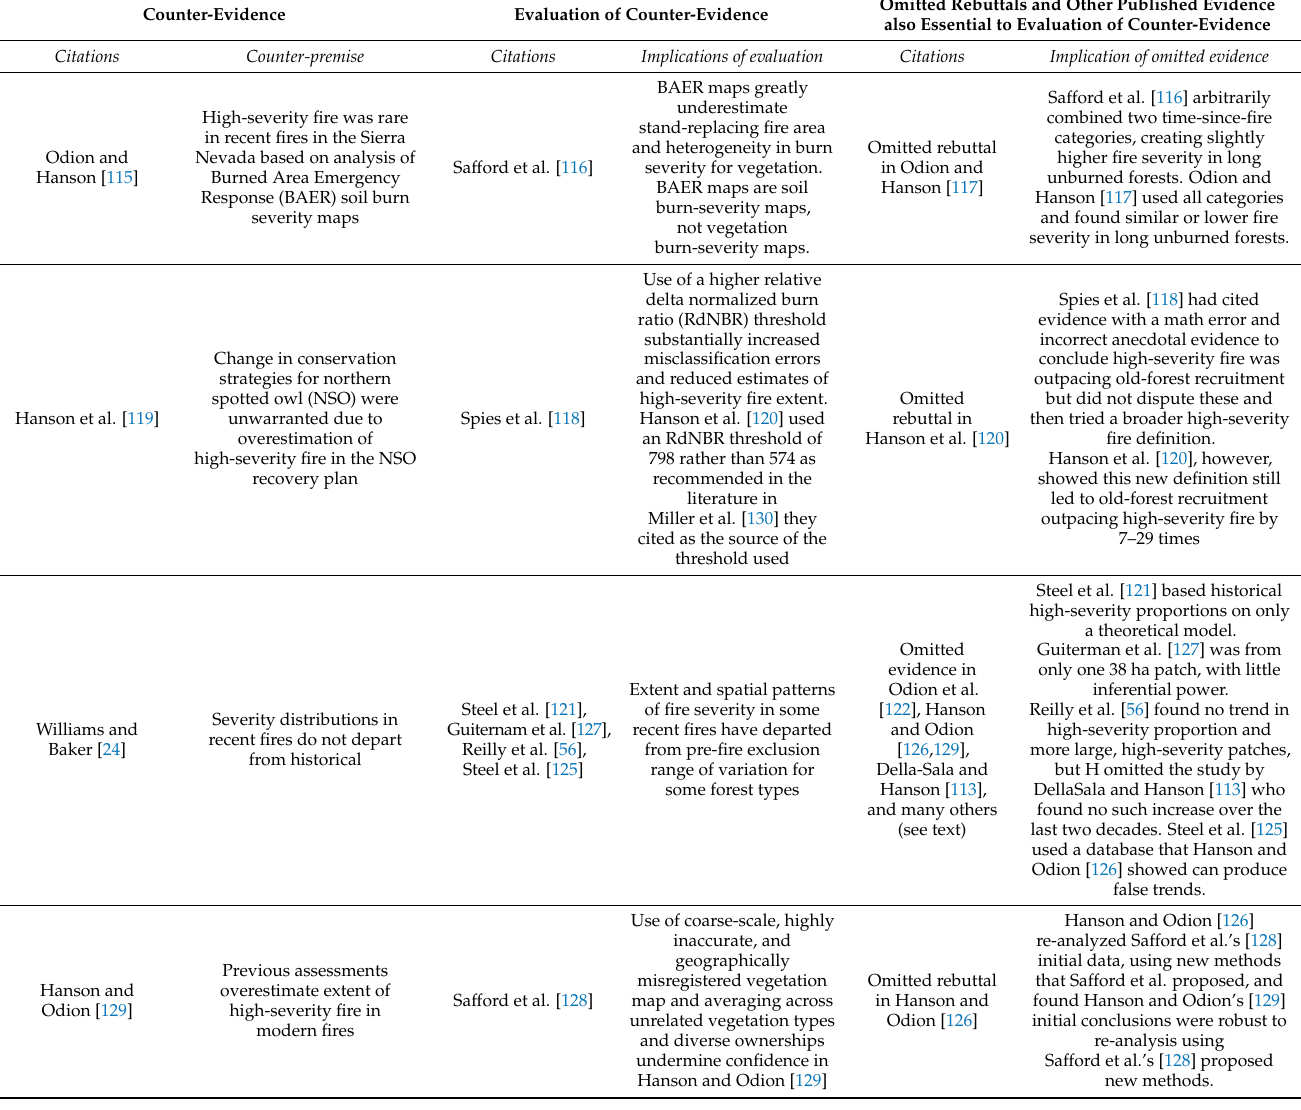
Table 6. Hagmann et al.’s study ([3] Table 6) about severity of modern fires is replicated in the left two columns, with omitted published evidence added in the right column, to show Hagmann et al. omitted published evidence and made incorrect conclusions as a